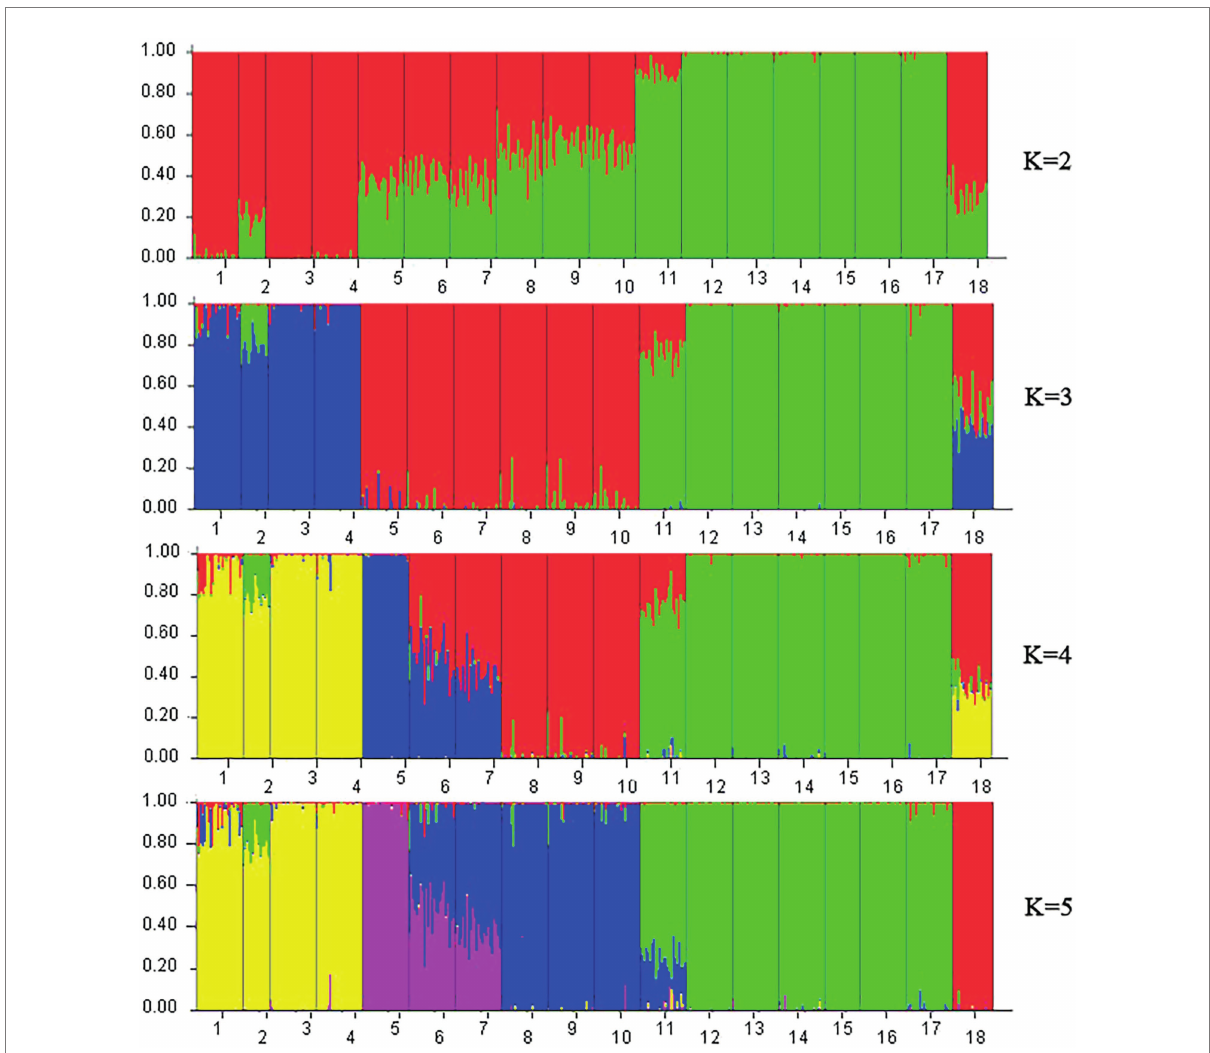
FIGURE 6 STRUCTURE analysis based on Bayesian clustering according to ISSR and SRAP data. Nos. 1–18 represent populations HZP, YML, HCX, CKX, TPY, BQY, WSG, TJG, LJTL, HTDL, JX, ZX, LS, XYL, MNL, MP, FH, and SNH,